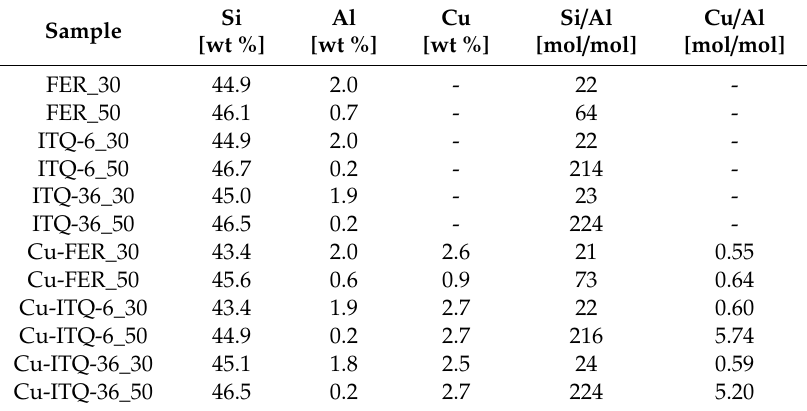
Table 2. Silicon, aluminum and copper contend in FER, ITQ-6 and ITQ-36